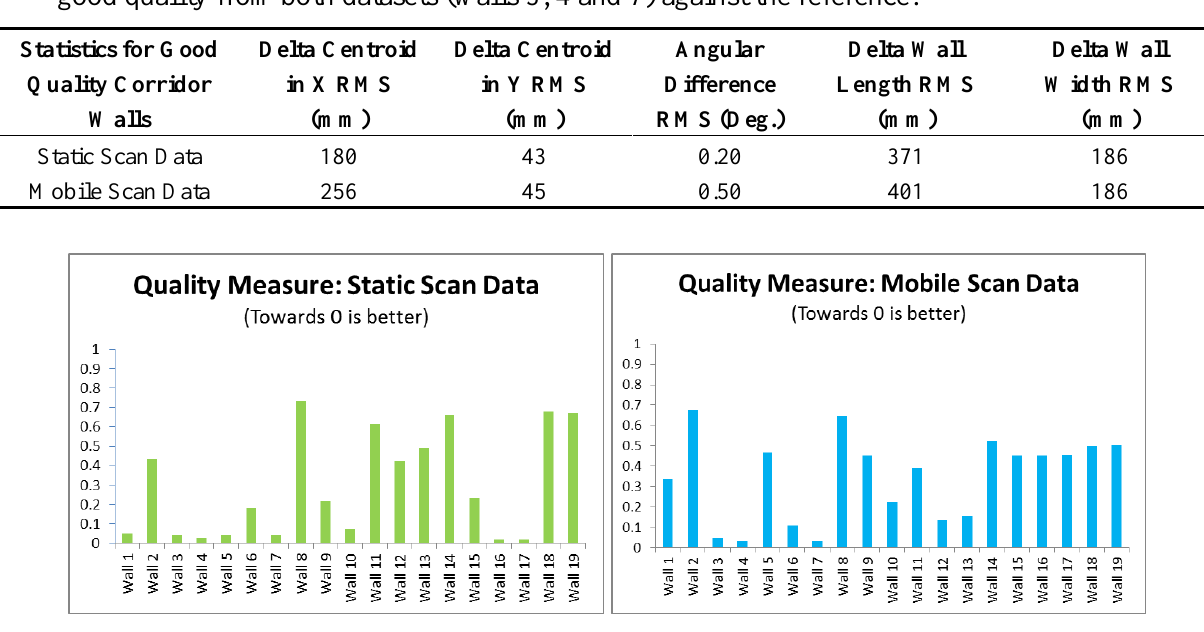
Figure 9. Charts of calculated reconstruction quality for each wall in the reference human-created model of the corridor against the automated geometry from the two scan datasets.